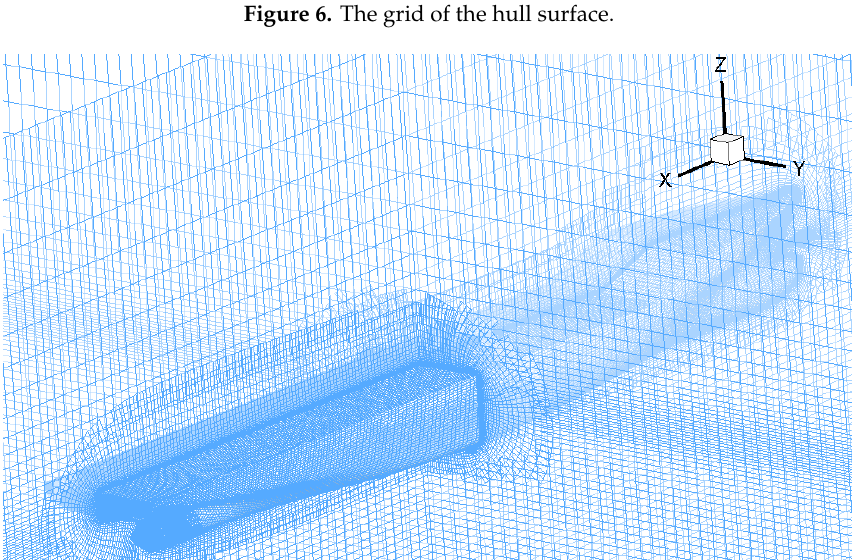
Figure 7. The overset grid of the computational domain.